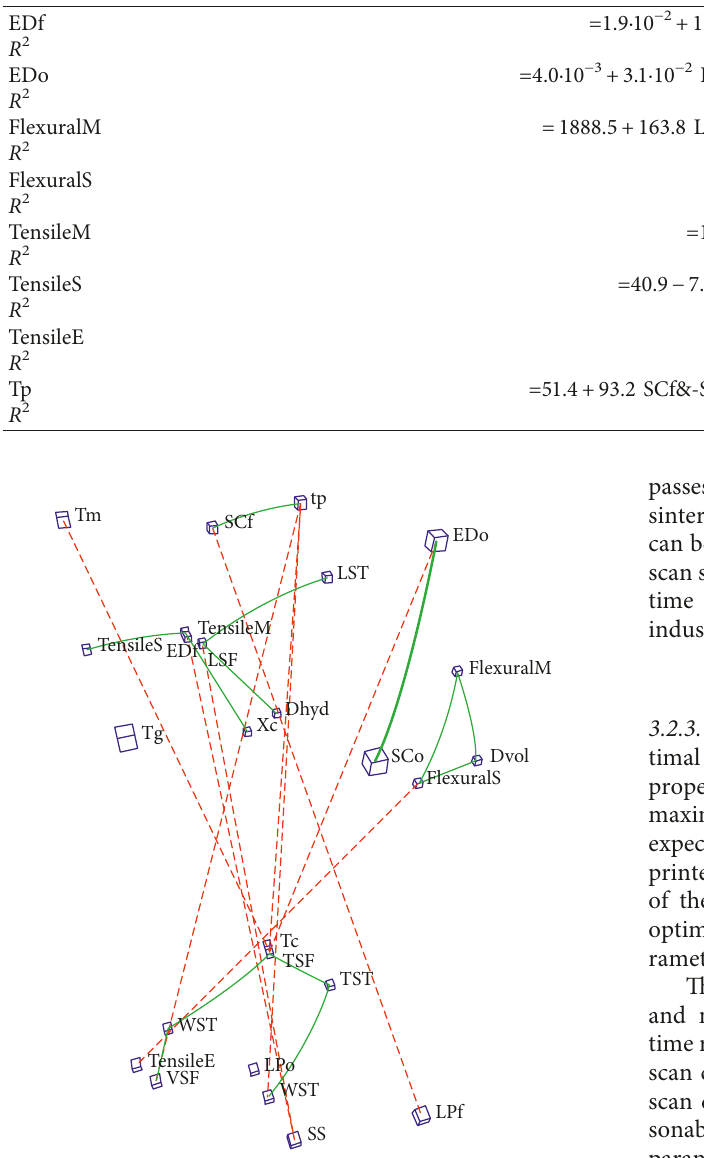
Figure 11: CORICO diagram of total results at threshold